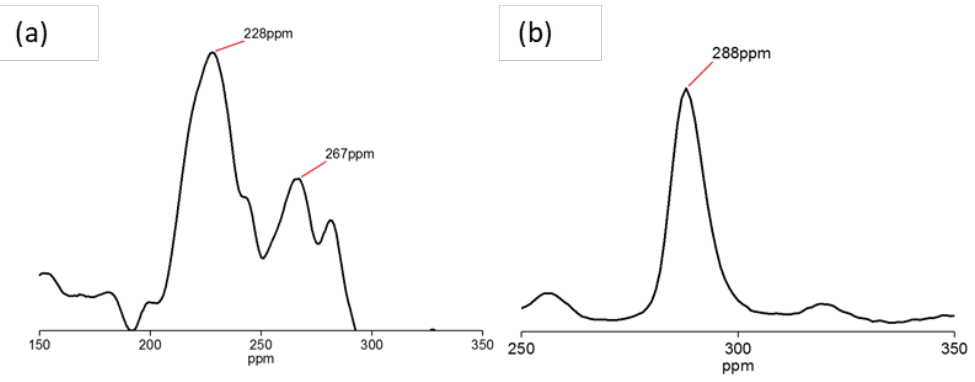
Figure 7. 27Al NMR of ( a ) HNT and ( b ) CTS-Si/HNT.